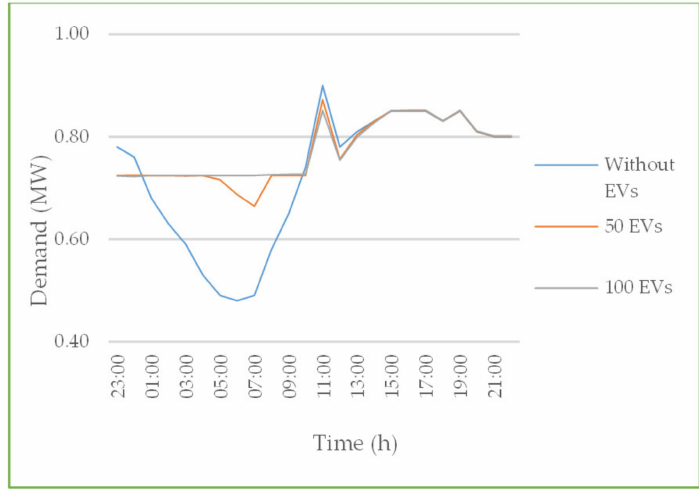
Figure 8. The effect of charging/discharging on LC2 when N = 50 and 100 cars with a random mobility pattern are used for valley filling or peak